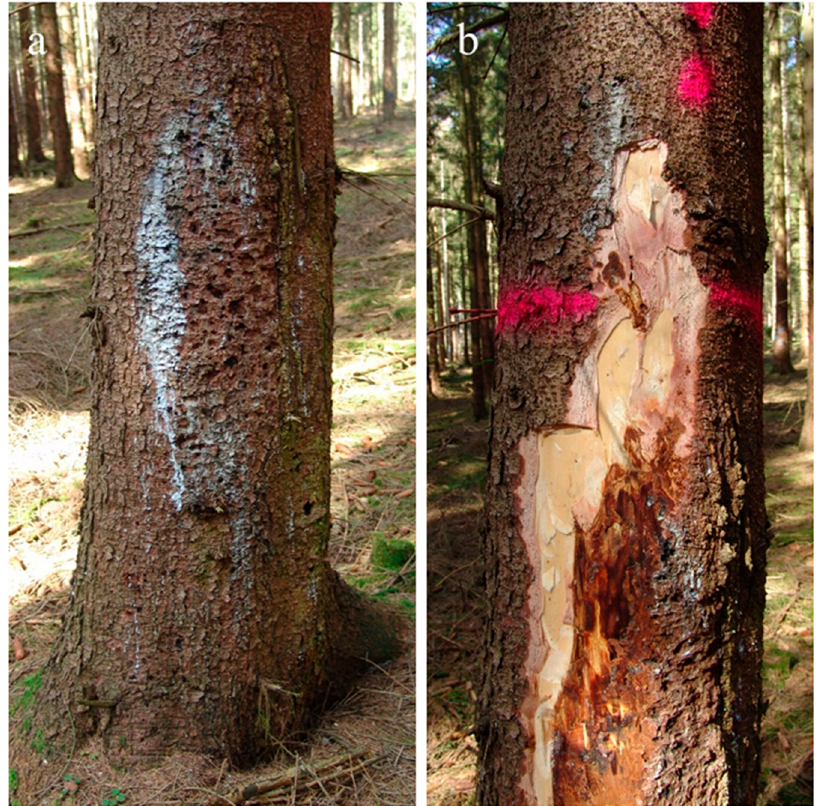
Figure 1. Resin flow on the stem is one of the symptoms that indicates the possible infection of H. annosum s.l. Living Norway spruce, confirmed to be infected by Heterobasidion annosum s.l.; ( a ) resinating stem necrosis; ( b ) stem necrosis with removed bark. These symptoms were observed more in the year 2012 in a forest stand close to Oerrel, Germany.